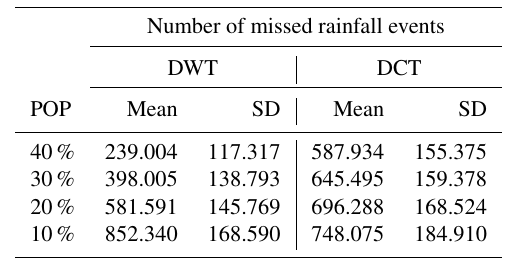
Table 2. The mean and standard deviation (SD) for the number of missed rainfall events for the DWT and DCT using a different num- ber of